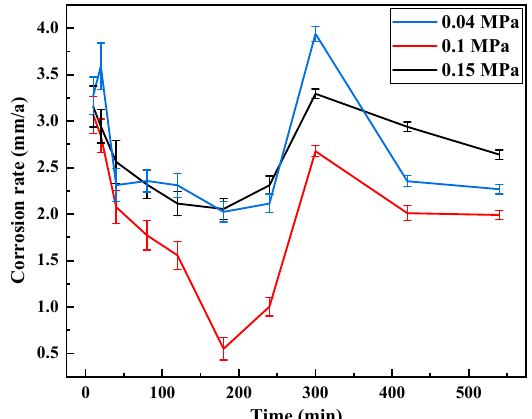
Figure 2. The corrosion rate curve versus the corrosion time of 20# steel under different CO 2 pressures in CO 2 /aqueous solution gas–liquid bubble flow.